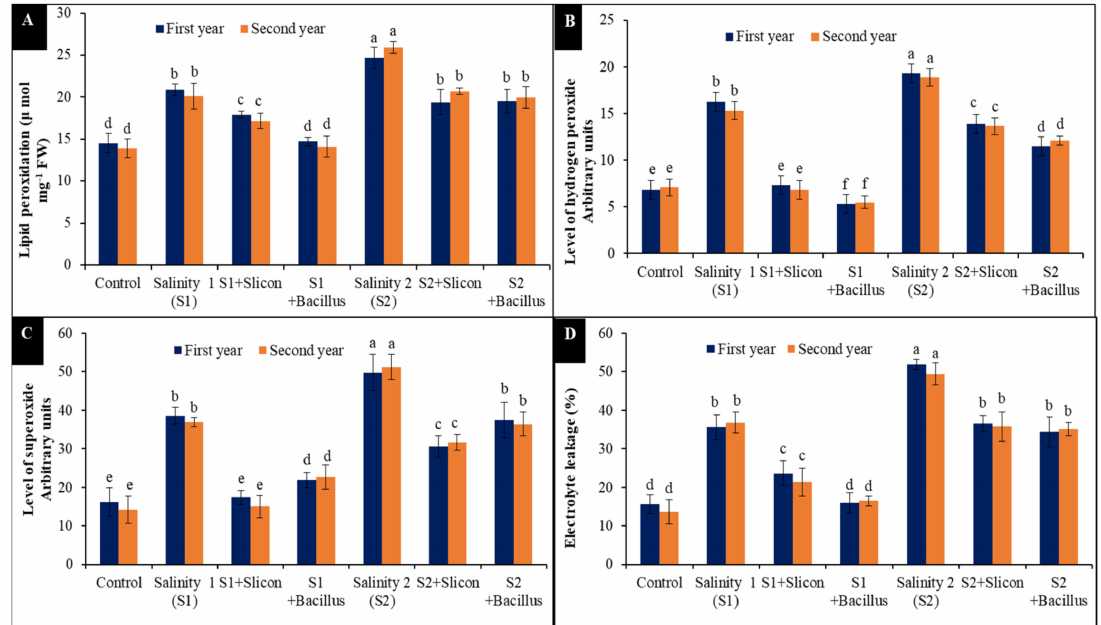
Figure 1. Effect of Si (potassium silicate at 2.7 mmol L − 1 ) and B. thuringiensis on lipid peroxidation (MDA) ( A ), H 2 O 2 ( B ), O 2 − ( C ), and EL ( D ) in lettuce plants under salinity during two seasons (2019/2020 and 2020/2021). Different letters on the columns show significant differences between the treatments according to ANOVA, Duncan’s multiple range test at 0.05 level. Data is the mean ( ± SE) of tree replicates. Salinity 1 (S1): 4 dS m − 1 , Salinity 2 (S2): 8 dS m − 1